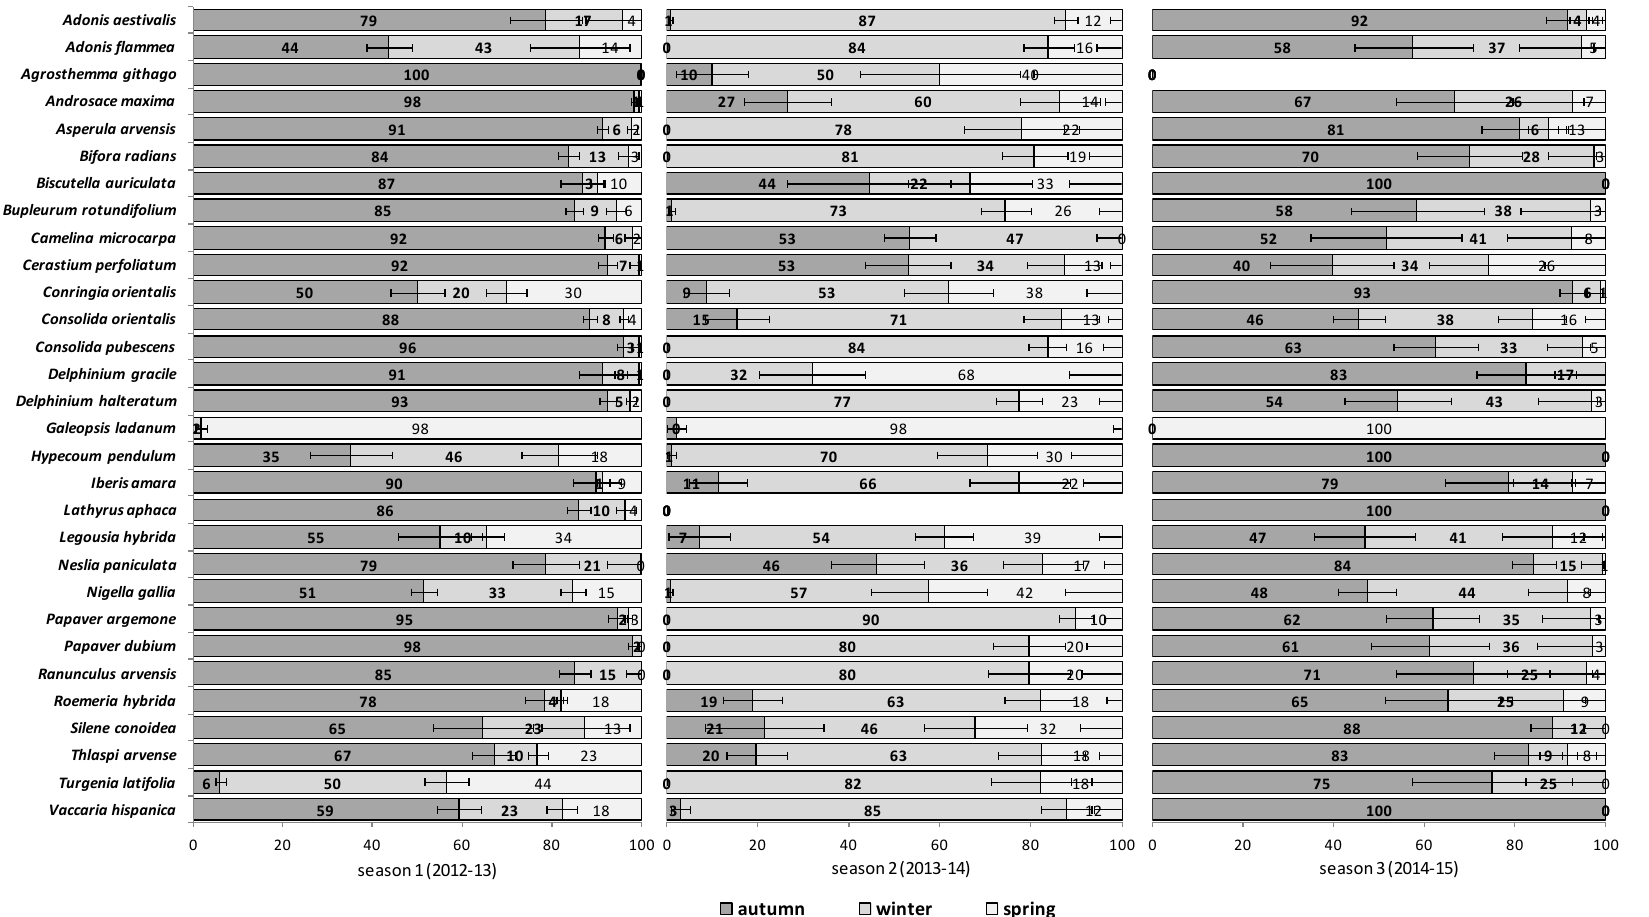
Figure 1. Relative Emergence patterns of 30 rare arable plants (RAP) in autumn (October through December), winter (January through February), and spring (March through April) during three consecutive seasons for seeds sown in 2012 (trial S1) in an arable field trial in Spain. Bars represent standard error. Two burial conditions are shown averaged: 1 cm burial depth without soil disturbance and 1–10 cm depth with annual autumnal soil disturbance. See Appendix A for relative emergence for each burial